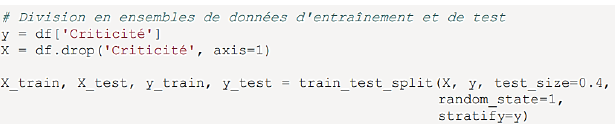
Fig. 11. Division into training and test datasets.